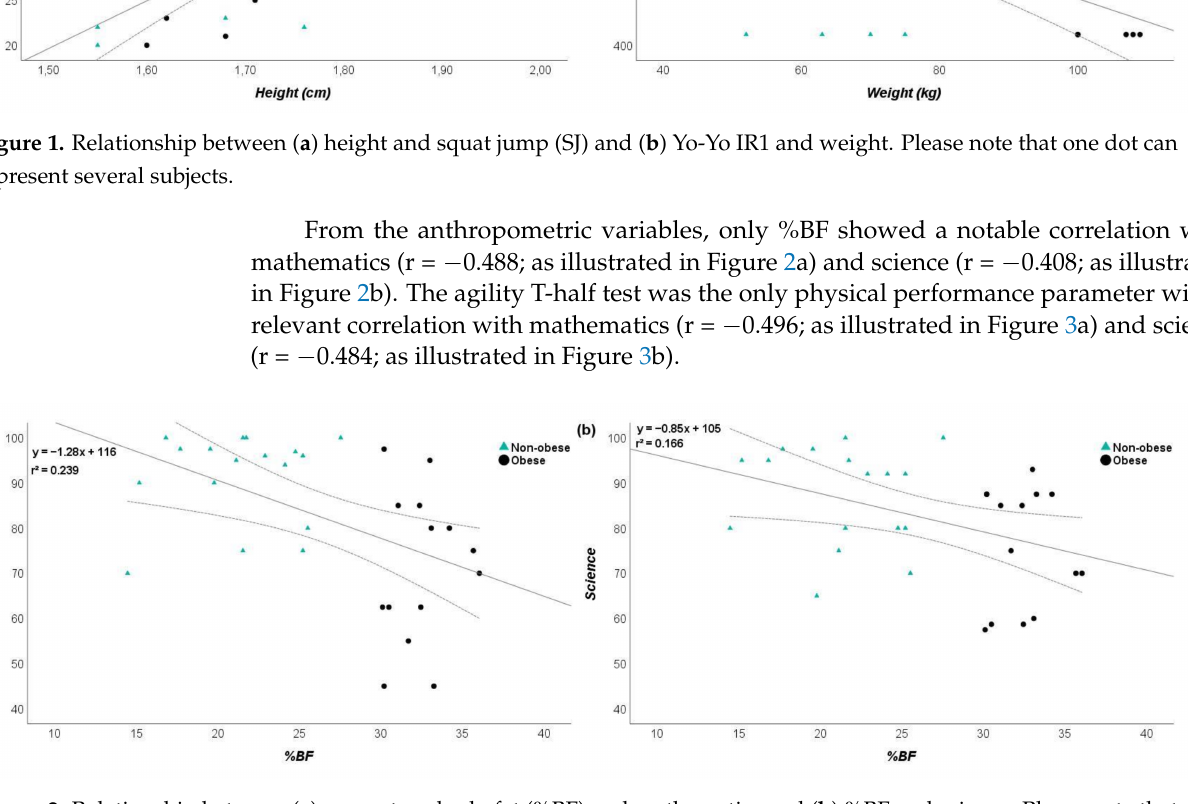
Figure 2. Relationship between ( a ) percentage body fat (%BF) and mathematics and ( b ) %BF and science. Please note that one dot can represent several